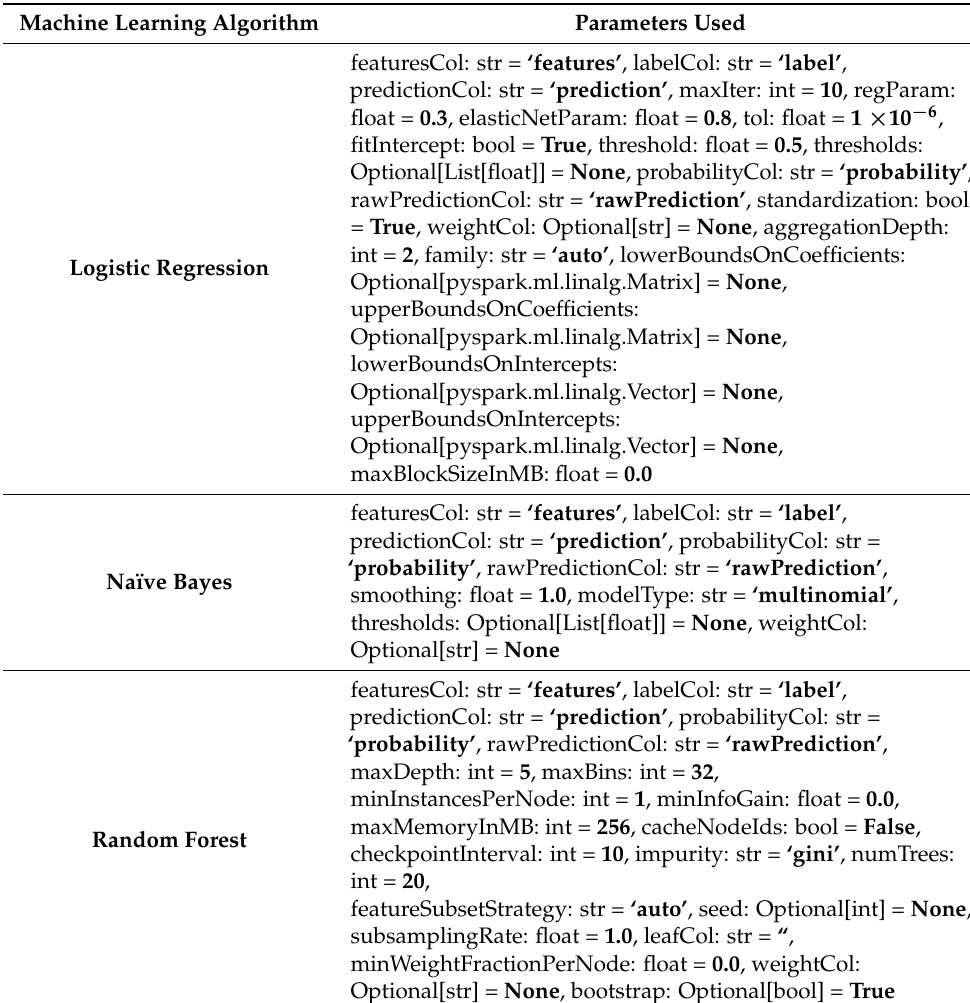
Table 13. Parameters specified for machine learning algorithm implemented in PySpark. Machine Learning